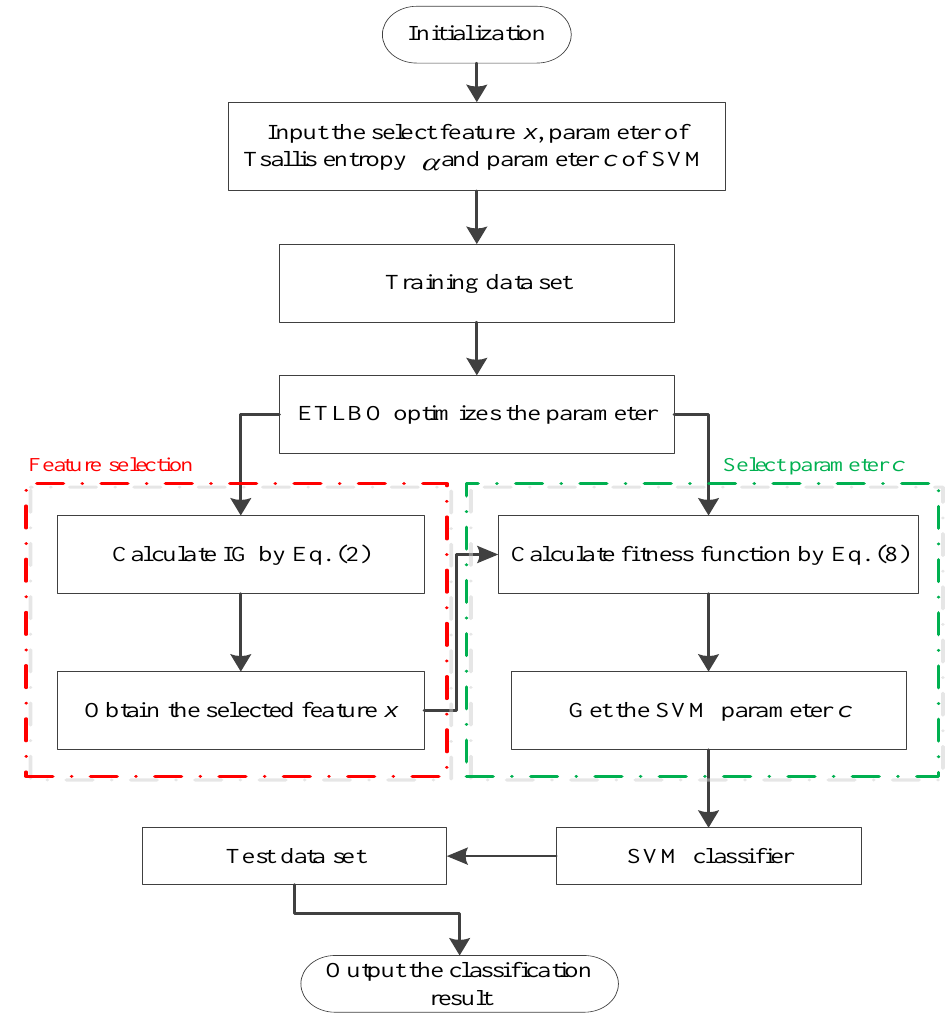
Figure 1. The flowchart of the proposed method.